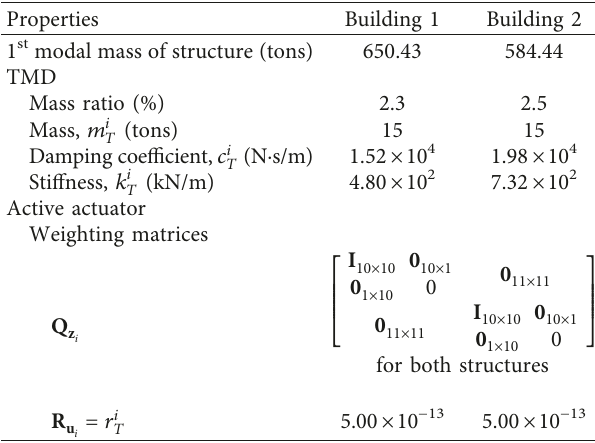
Table 4: CAS design